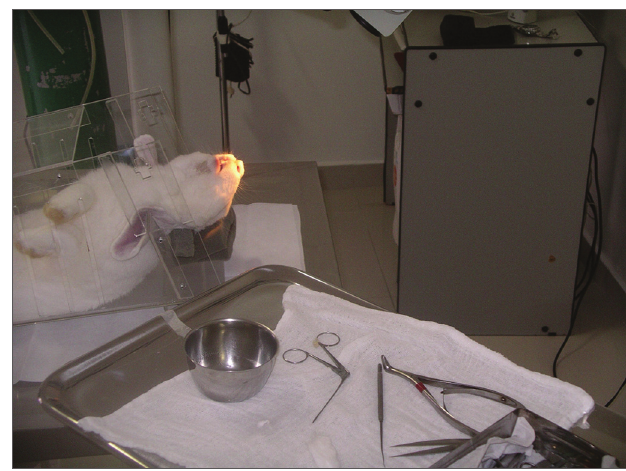
Figura 2. Coelho posicionado e anestesiado para o